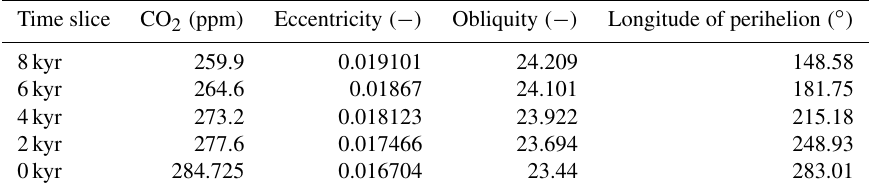
Table 2. CO 2 concentrations (in ppm) and orbital parameters for simulated time slices at 8, 6, 4, 2, and 0kyr. For palaeo simulations, CO 2 concentrations are taken from Fortunate Joos (personal communication, 2016) and orbital parameters are adjusted according to Berger (1978). The values for 0kyr conform to the standard pre-industrial set-up of MPI-ESM. Time slice CO 2 ( ppm ) Eccentricity ( − ) Obliquity ( − )